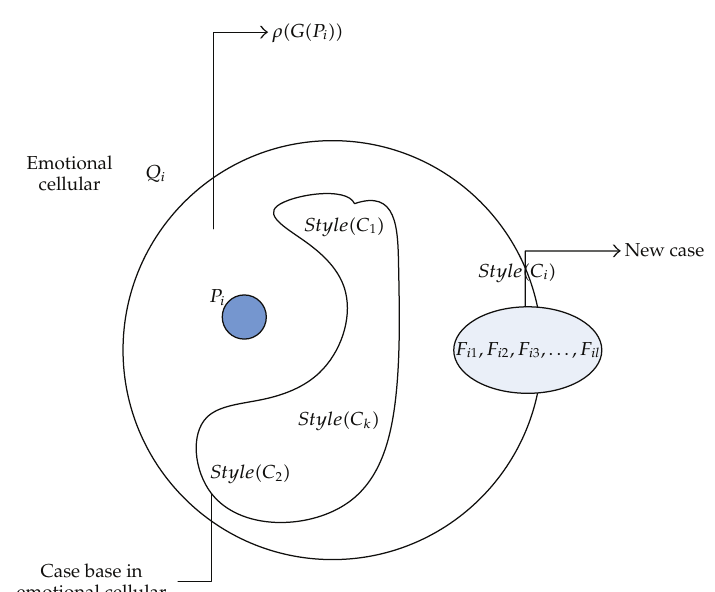
Figure 5: Similarity computing for new case in valence-arousal emotional space.